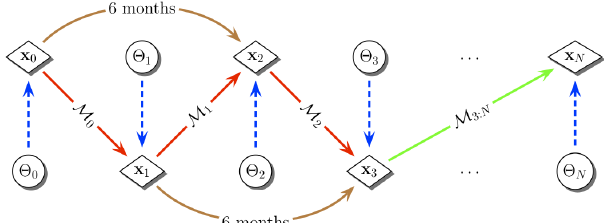
Figure 5. A sketch illustrating the procedure followed to construct the background statistics, P b xx and P b ; 3-month forecasts are per- θx formed starting from different initial conditions, x 0 , 1 ,...,N , and dif- ferent degradations rate parameters, (cid:50) 0 , 1 , 2 ,...,N , where N = 200 steps summing up to 50 years. The background state covariance, P b xx , and state-parameter cross-correlations, P b , are then con- θx structed using the first leading modes